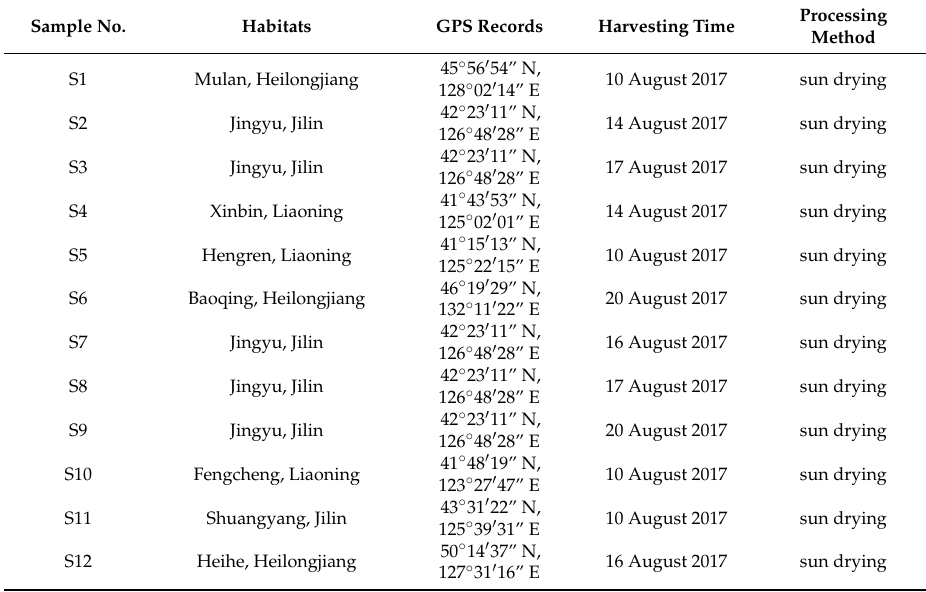
Table 3. Detailed information of